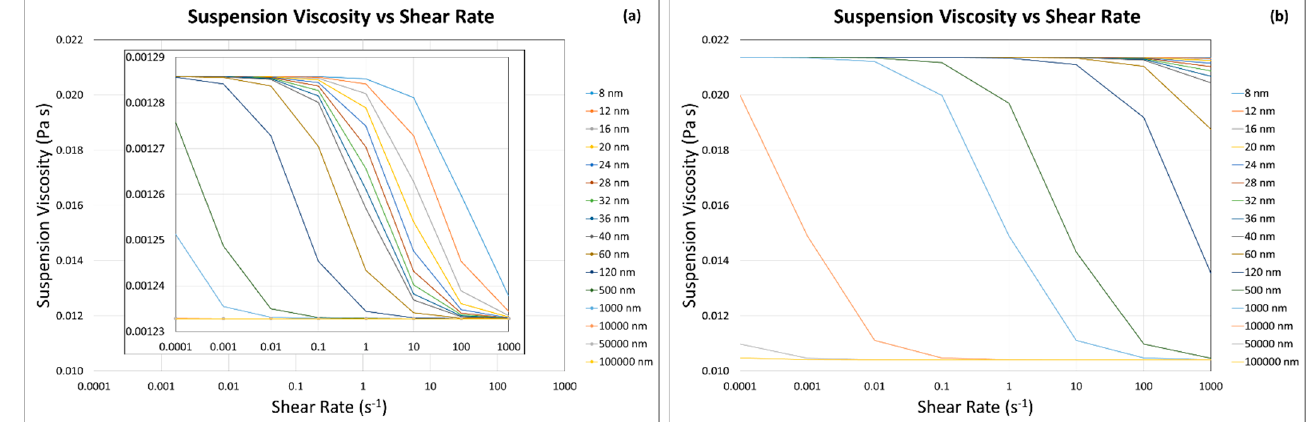
Figure 4. Suspension viscosity as a function of shear rate calculated by the modified Krieger and Dougherty model at ( a ) solid fraction, ϕ = 0.1, and ( b ) solid fraction, ϕ = 0.5. Note: the major y-axis of subfigure ( a ) is made for the purpose of comparison.